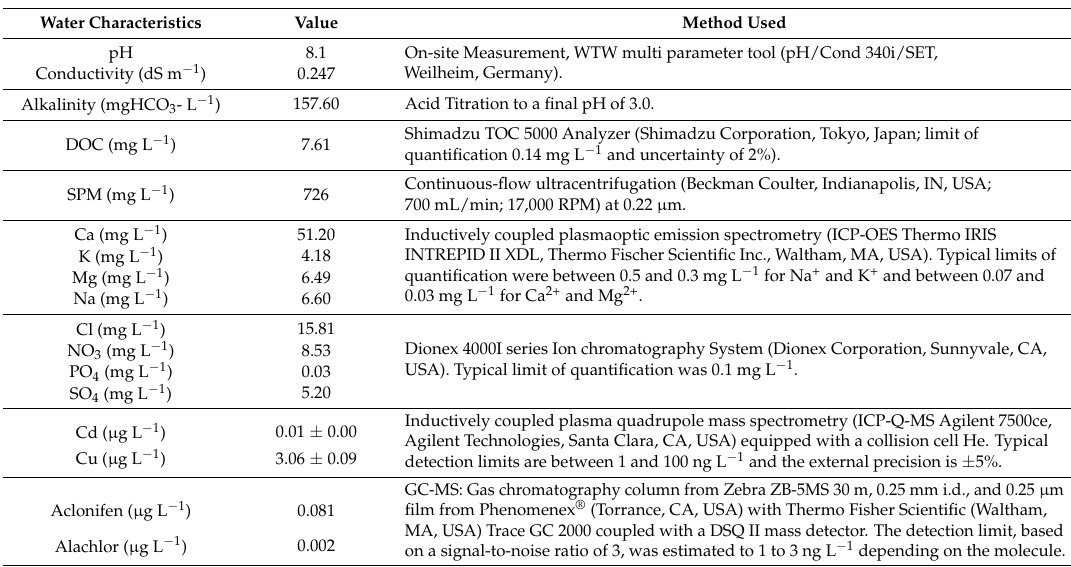
Table 2. Physico-chemical characteristics of the filtered peak water used in the adsorption experiments. Details of the methods used can be found in [12].